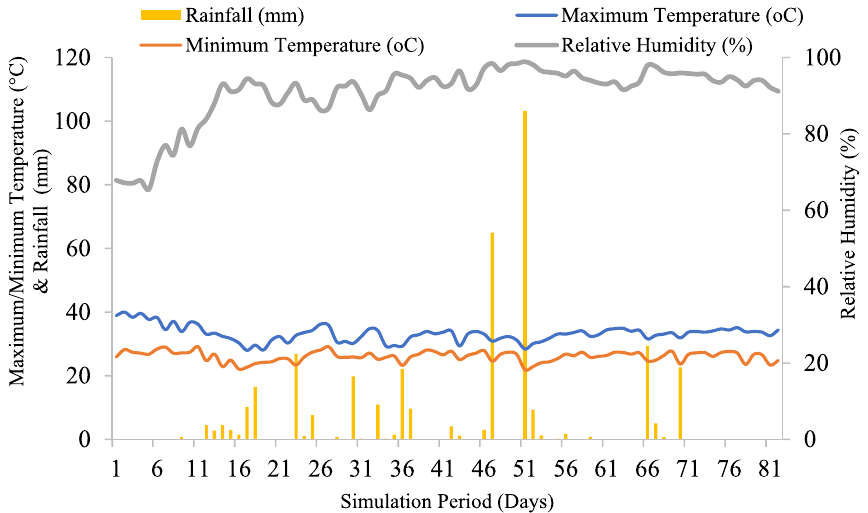
Figure 7. Daily weather conditions during simulation period (Day 1 corresponds to 28th June, 2019 and the day 82 corresponds to 17th Sep,